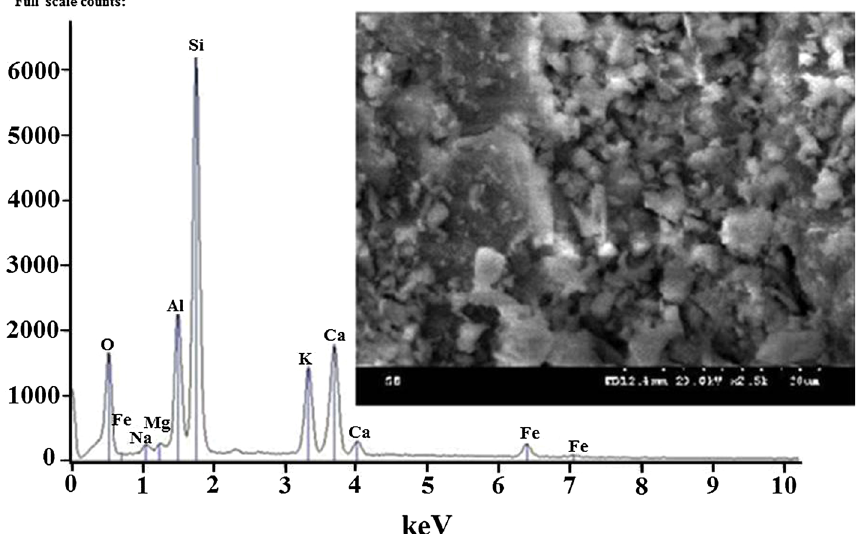
Fig. 5 SEM analysis for